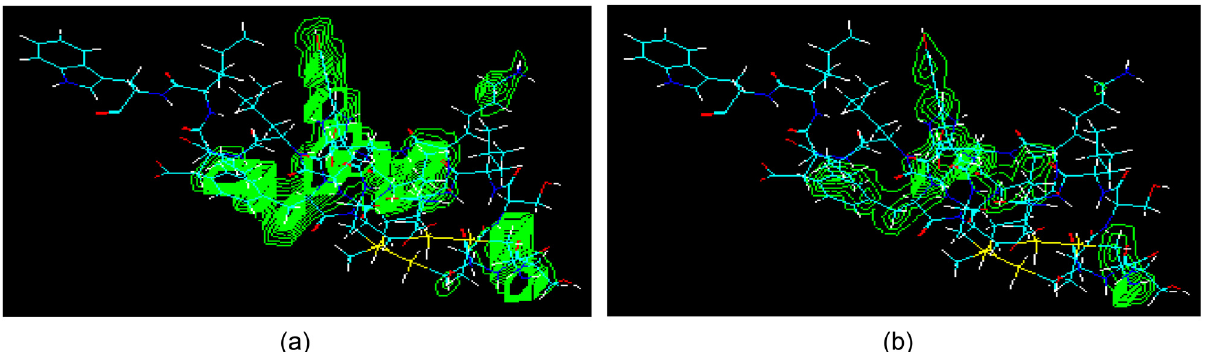
Figure 8: ET - I: electrostatic potential and charge density; ( a ) electrostatic potential on the ET - I molecule after dual cyclization, a 2D representation; ( b ) total charge density presented as 2D contours, dense lines represent strong in fl